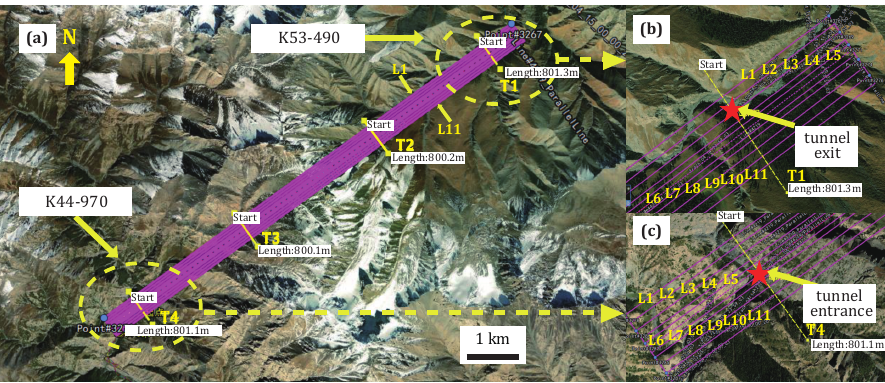
Figure 2. Flight line map over a satellite image. ( a ) General survey line layout. ( b ) Tunnel exit survey line layout. ( c ) Tunnel entrance survey line